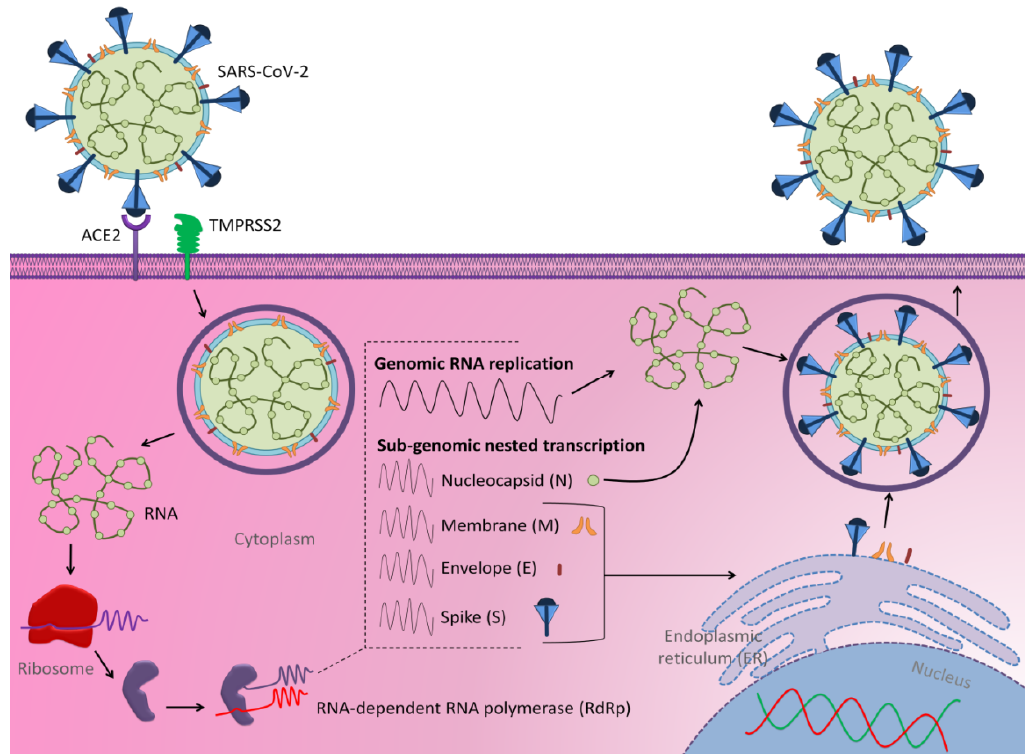
Figure 1. Structure scheme of SARS-CoV-2 and its mechanisms of cell entry and replication (adapted from Al-Hatamleh et al., 2020 [2]).